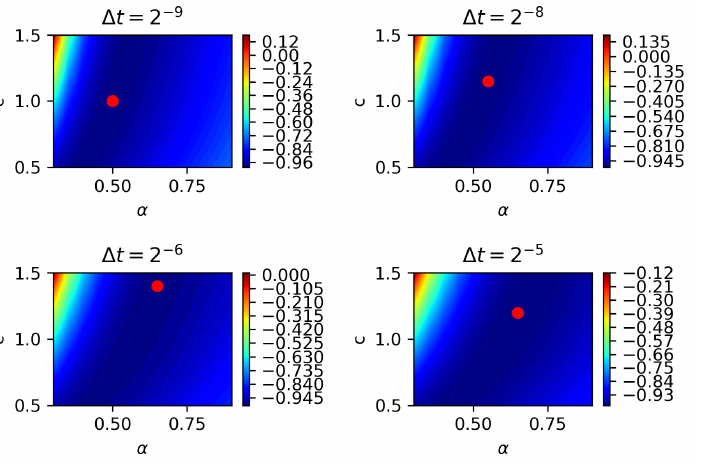
Figure 8. Two-parameter estimation: Contour plots of normalized negative log-likelihood for pairs of ( α , c ) ∈ [ 0.3,0.9 ] × [ 0.5,1.5 ] . The effect of temporal step on the estimated parameters is